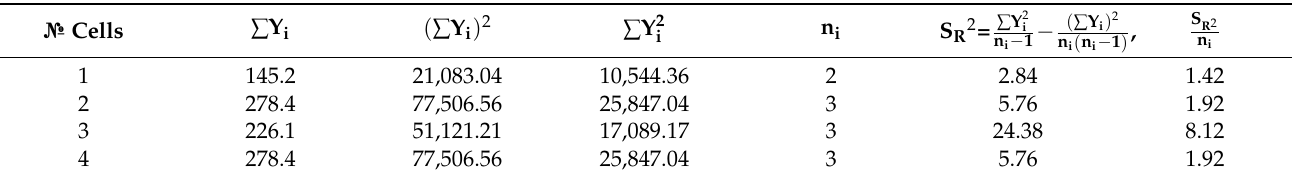
Table 5. Table for calculating